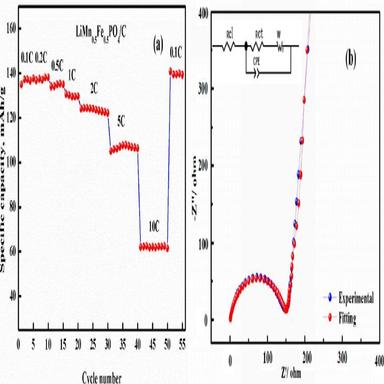
(a) Rate performances of LiFe0.5Mn0.5PO4/C samples at different current rates starting from 0.1 C to 10 C. (b) Electrochemical impedance spectroscopy (EIS) of LiFe0.5Mn0.5PO4/ C composite.